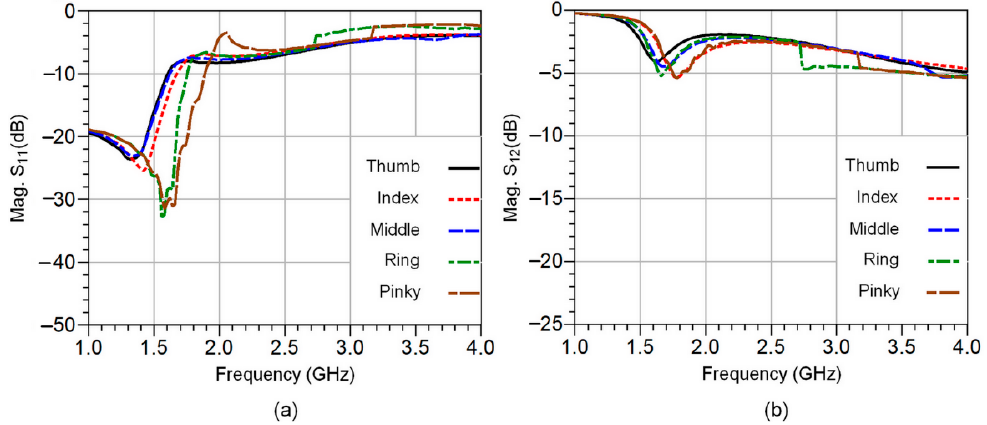
Figure 7. The simulated S-parameters of the CSRR sensor circuit for all five fingertips: the reflection coefficients in ( a ) and transmission coefficients in ( b ).